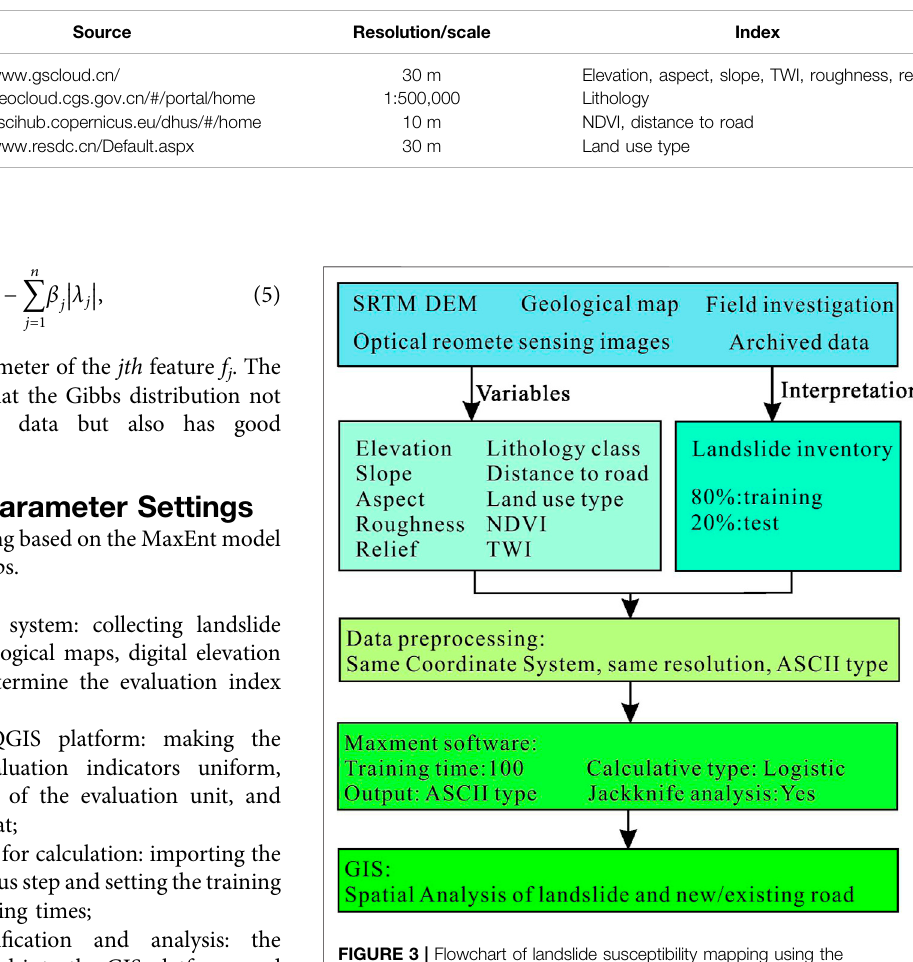
FIGURE 3 | Flowchart of landslide susceptibility mapping using the MaxEnt